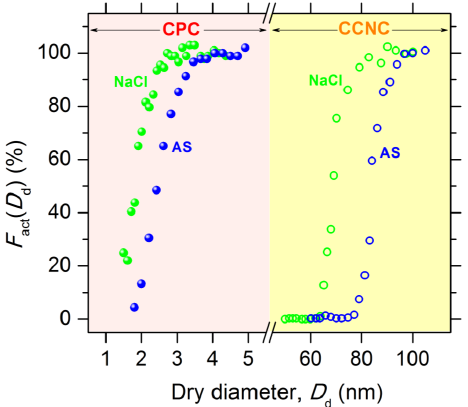
Figure 3. The symmetry between counting efficiency of a CPC (condensation particle counter, TSI model 3786) and the activa- tion curve of a CCNC (cloud condensation nuclei counter, DMT CCNC). The green and blue circles represent the results for sodium chloride (NaCl) and ammonium sulfate (AS) particles, respectively. The CPC was operated with a growth tube temperature and a satu- rator temperature of 78 and 8 ◦ C, respectively (Mordas et al., 2008). The CCNC was operated with a temperature difference of 4.5K across the growth chamber (Moore et al., 2010).